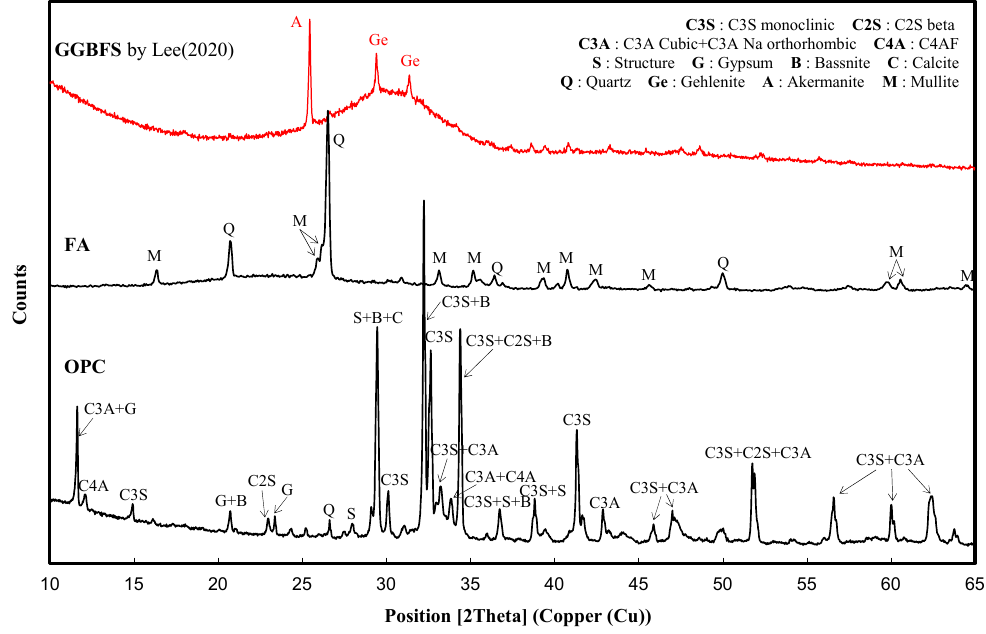
Figure 4. X-ray diffraction patterns of OPC and FA compared with GGBFS as measured by Lee, adapted from [26].